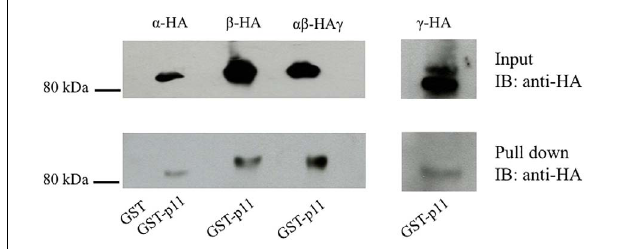
FIGURE 1 | p11 interacts with all three epithelial Na + channel (ENaC) subunits. HA-tagged ENaC subunits were transiently expressed alone or together as an αβ HA γ channel complex in COS-7 cells. Cells were then lysed, pre-cleared with GST bound to glutathione-agarose beads and then incubated with 50 µ g of GST alone or GST-p11. After washing, bound proteins were eluted and analyzed by SDS-PAGE and immnoblotting (IB) with anti-HA antibody. The top panel labeled ‘Input’ shows the successful expression of each subunit (Mr 85 kDa). The bottom lane labeled ‘Pulldown’ shows binding of each ENaC subunit and the channel complex to GST-p11. The GST lane indicates that no ENaC subunits interacted with GST alone. Data shown are representative of three independent experiments with similar results.